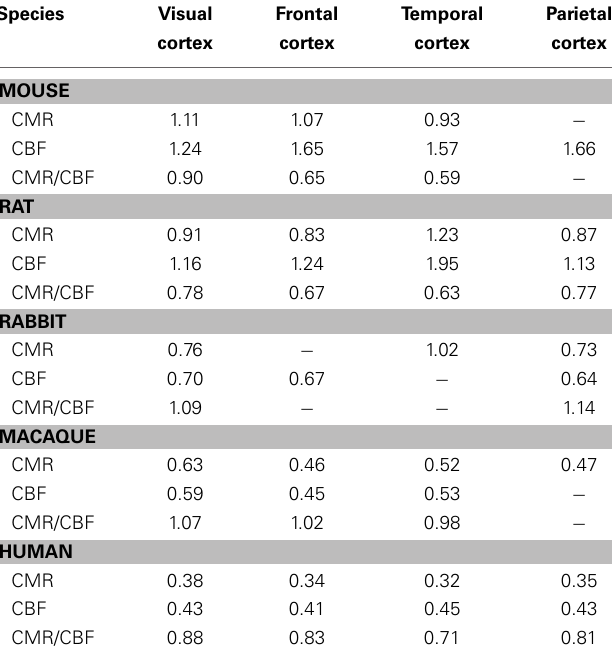
FIGURE 3 | Metabolic energy flow in the brain (see description in Box 1). It is based on diagrams from Attwell et al. (2010) and Belanger et al. (2011).